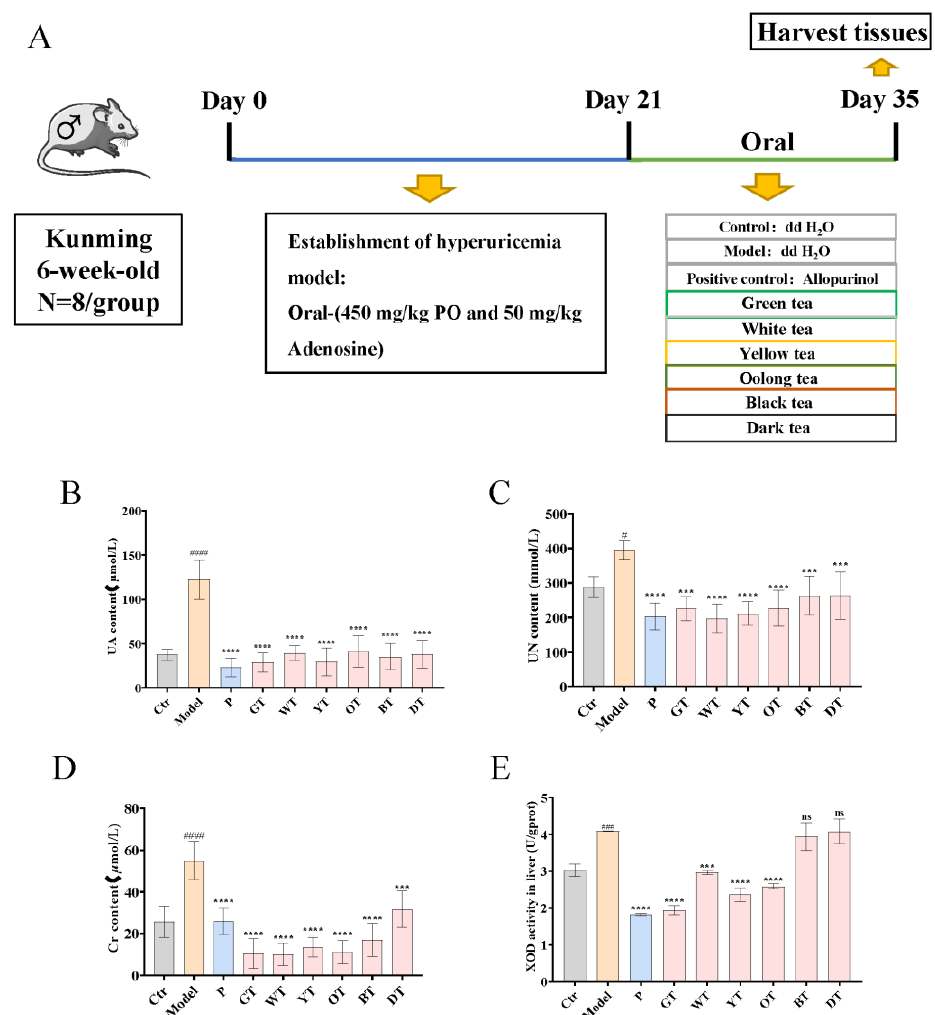
Figure 1. Effects of TWEs on UA-related indexes and antioxidant levels in HUA mice. ( A ) Study design for the whole experiment; ( B ) Serum UA levels. ( C ) Serum UN levels. ( D ) Serum Cr levels. ( E ) Liver XOD activity. The data are expressed as mean ± SD. # p < 0.1, ### p < 0.001, #### p < 0.0001 were compared with the control, ns p > 0.1, *** p < 0.001, **** p < 0.0001 were compared with the model.